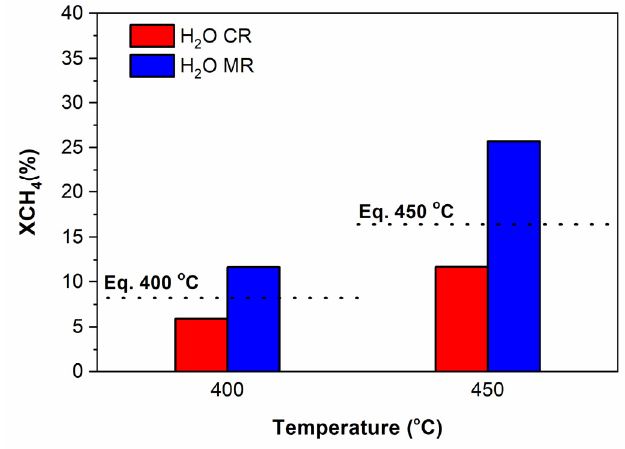
Figure 13. Effect of co-feeding H 2 O (2 vol.%) on the activity over Ru/ZrO 2 -La 2 O 3 catalyst at 400 and 450 °C in the MR and a CR; Feed composition: CH 4 :CO 2 :H 2 O:He = 10:10:2:78; Total flow rate = 100 mL/min: P = 1 bar. Sweep Gas: 300 mL/min (MR). The dotted line represents the thermodynamic CH 4 conversion value at a given temperature.